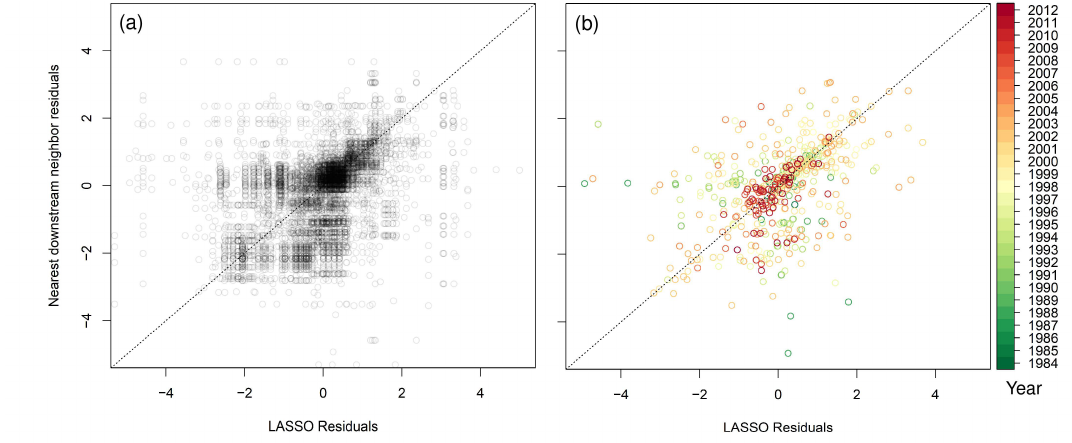
Figure 5. Comparison of the LASSO residuals with respect to the residual of the corresponding nearest downstream neighbors. The units of the residuals are mg/L. Panel ( a ) includes all neighboring pairs regardless of the year while panel ( b ) only includes neighboring pairs from the same year, and the color bar represents the corresponding